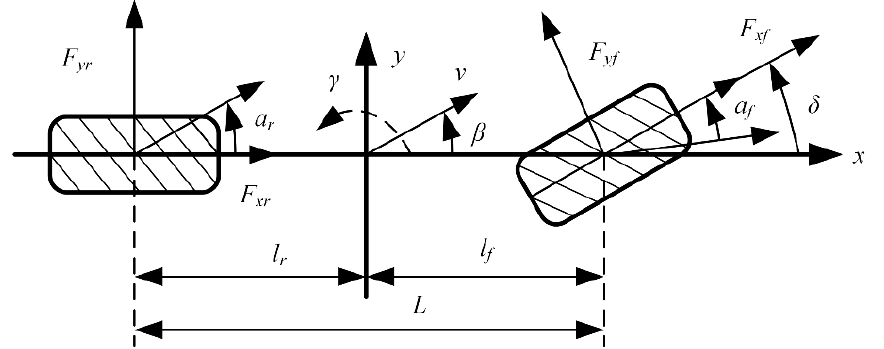
Figure 1. Vehicle linear 2-DOF model.